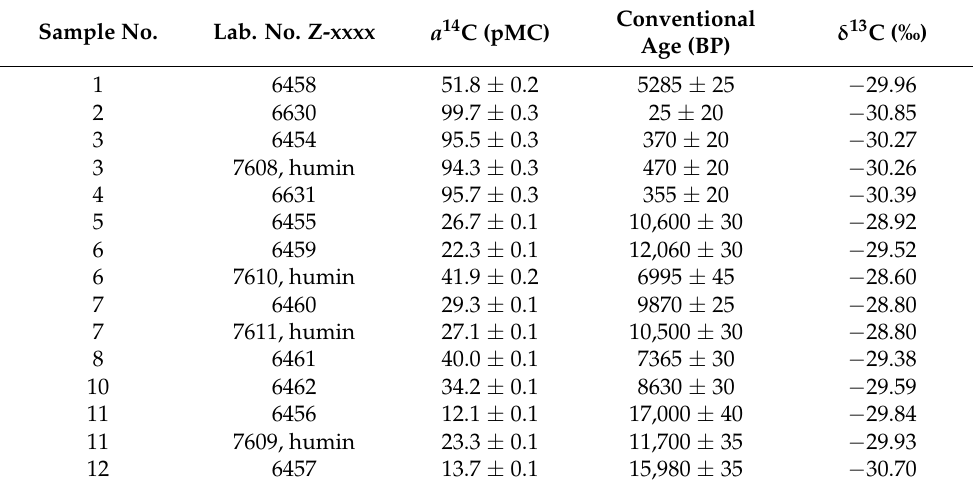
Table 3. a 14 C, radiocarbon dates and δ 13 C values of the organic residues and the humin of